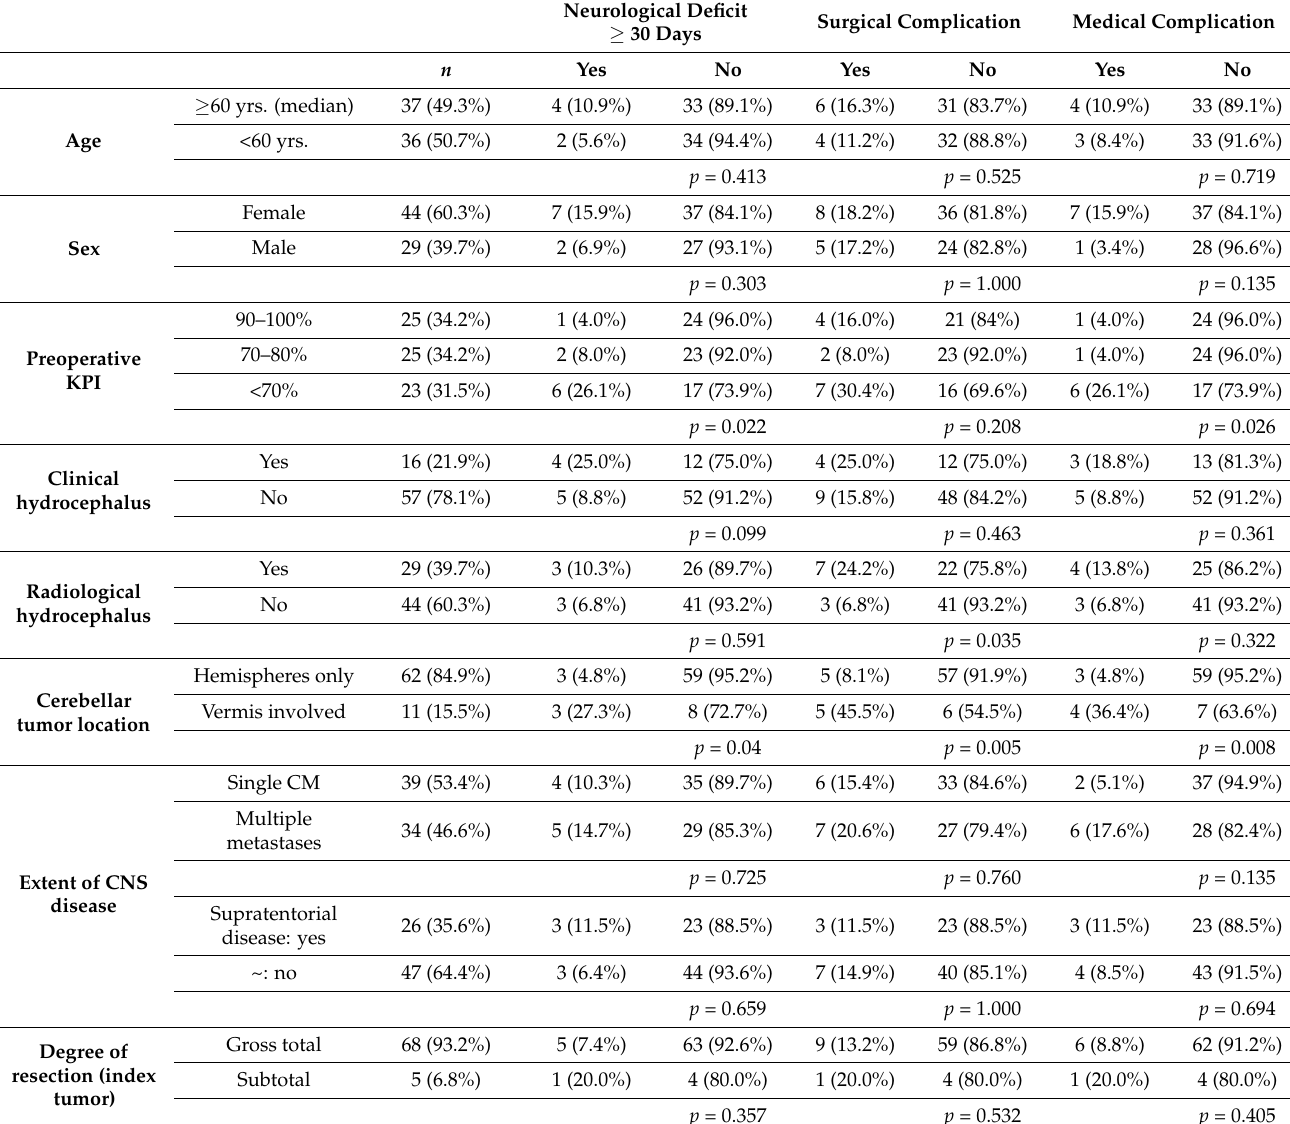
Table 1. Patient and metastases characteristics and neurological, surgical, and medical CTCAE grade III–V